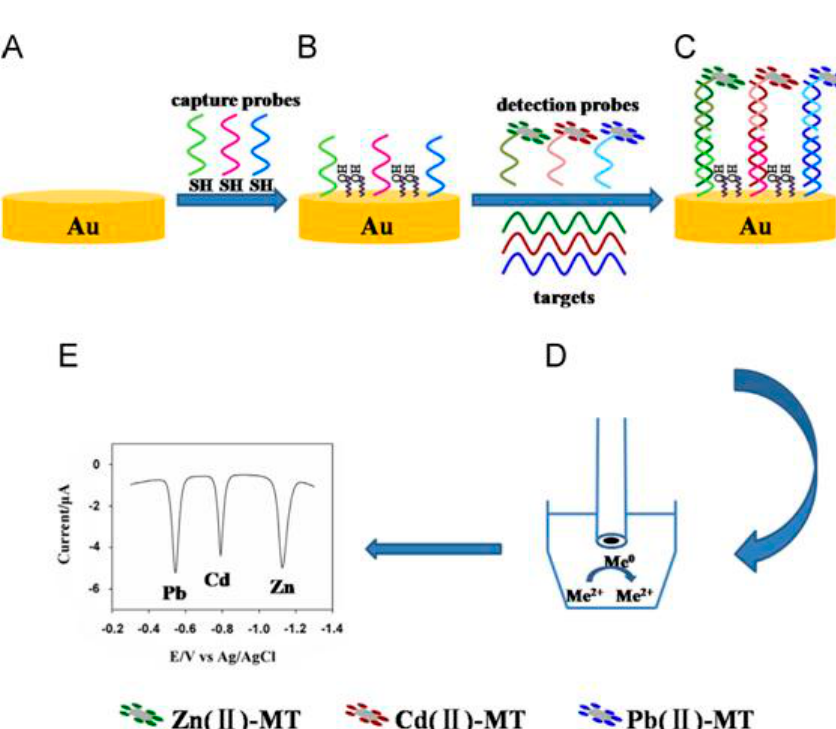
Figure 8. Schematic illustration of sandwich DNA hybridization assay for simultaneous determination of the three pathogens using PbS, CdS, and ZnS QDs. Reproduced from [67], with permission from Elsevier, 2019.